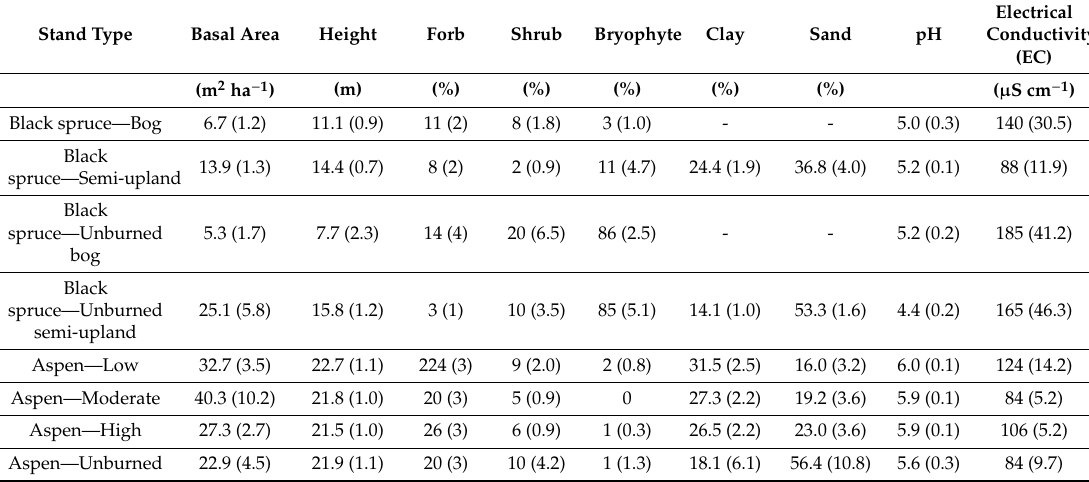
Table 1. Pre- and post-fire stand characteristics for each stand type sampled. Values are average (standard error), n = 12 for each stand type. Pre-fire forests were all comprised of ≥ 80% either aspen or black spruce; other tree species were not